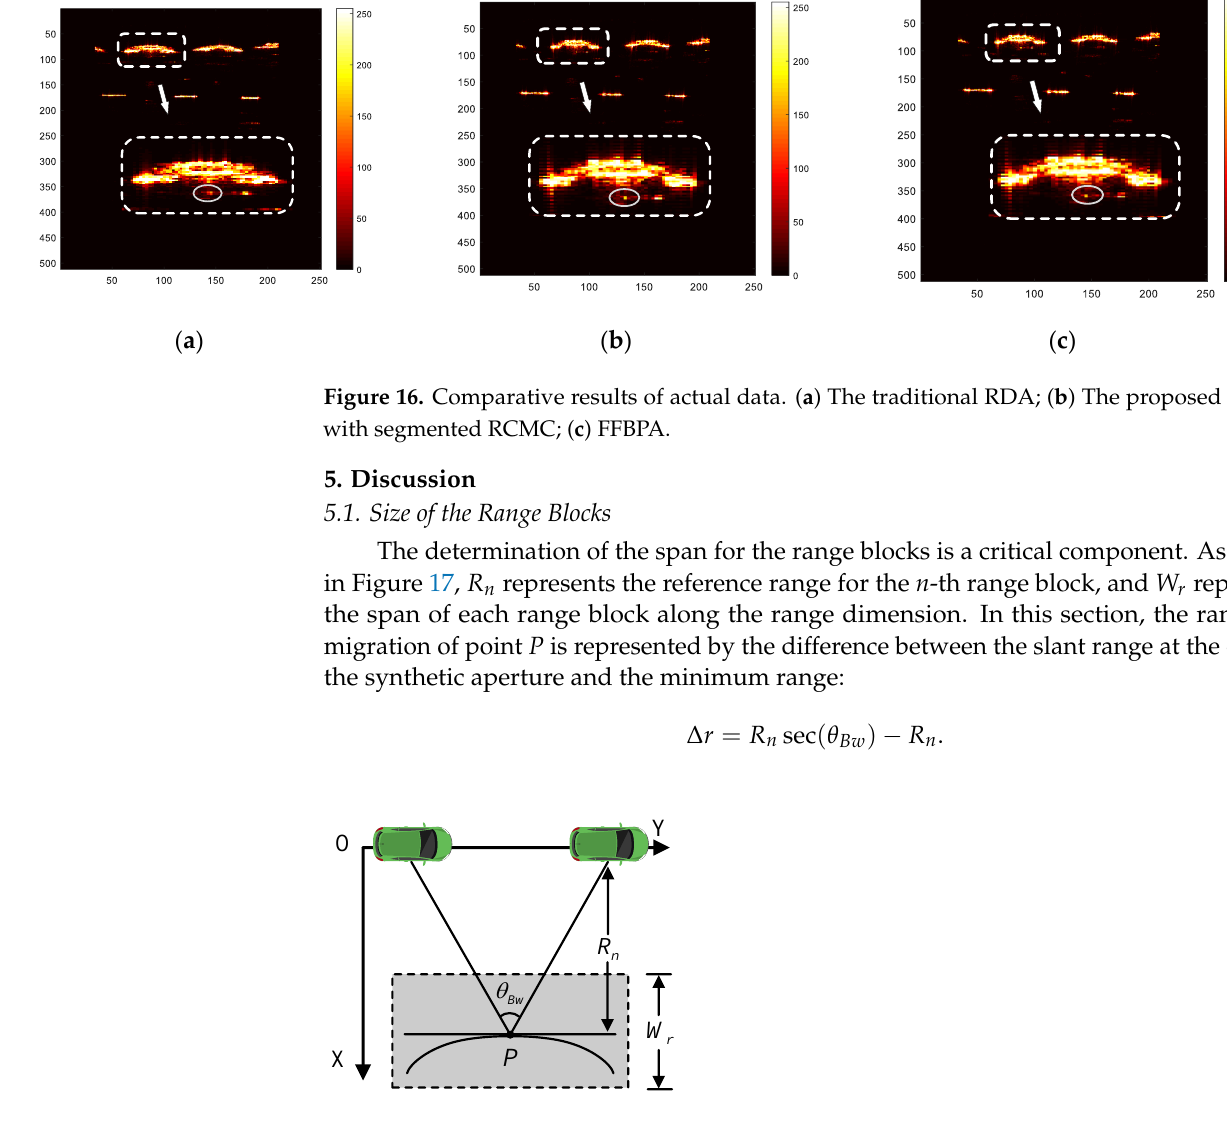
16 of 20 Figure 15. ViSAR imaging result of actual data. ( a ) First frame image; ( b ) Second frame image; ( c ) Third frame image; ( d ) Fourth frame image; ( e ) Fifth frame image; ( f ) Sixth frame image. Figure 16 shows the comparison results of actual data by RDA and FFBPA. In this article, image entropy was used to quantitatively evaluate the imaging results of the actual data. For SAR images, it is generally believed that the smaller the image entropy, the better